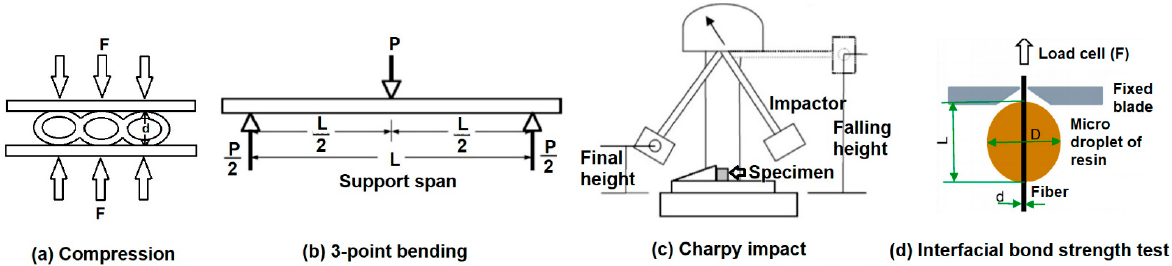
Figure 5. Principles of ( a ) compression test, ( b ) 3-point bending test, ( c ) Charpy impact test, and ( d ) fiber-matrix interfacial bond strength test.